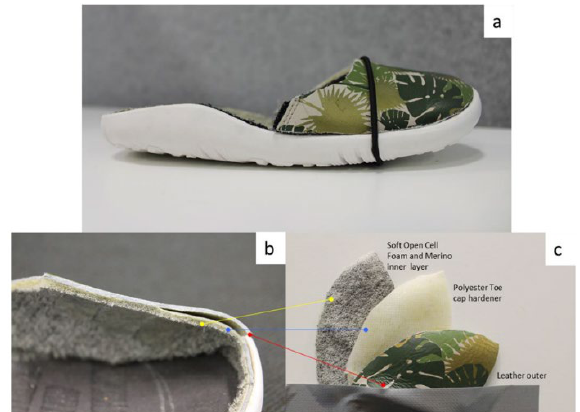
Figure 2. ( a ) Example of Bobux shoe with midsole removed; ( b , c ) Upper of the toe area showing the cross-section and layers of the shoe.